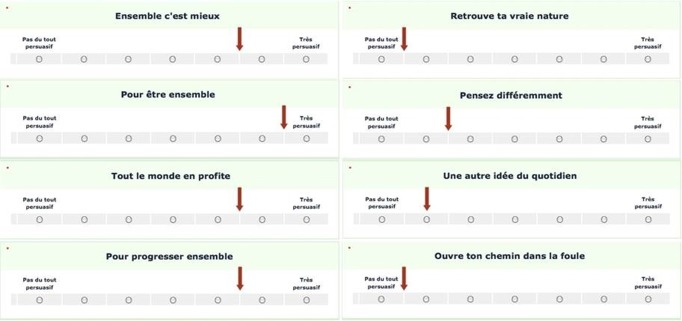
The messages used in Studies 2–3 for the induction of the collectivistic ingroup norm.On each message, the red arrow indicates the mean ratings of ingroup university students in the alleged previous study. In this condition, collectivistic messages (left panel) had high means, whereas individualistic messages (right panel) had low means (in the individualistic condition, the pattern of means was reversed). The original messages were presented in French. Hereafter, we provide the English translation for each type of messages (from top to bottom). Collectivistic messages: “Together, it’s better”, “To be together”, “Everybody benefits” and “To move forward together”. Individualistic messages: “Find your true nature”, “Think differently”, “Another idea of everyday life” and “Open your own path in the crowd”.